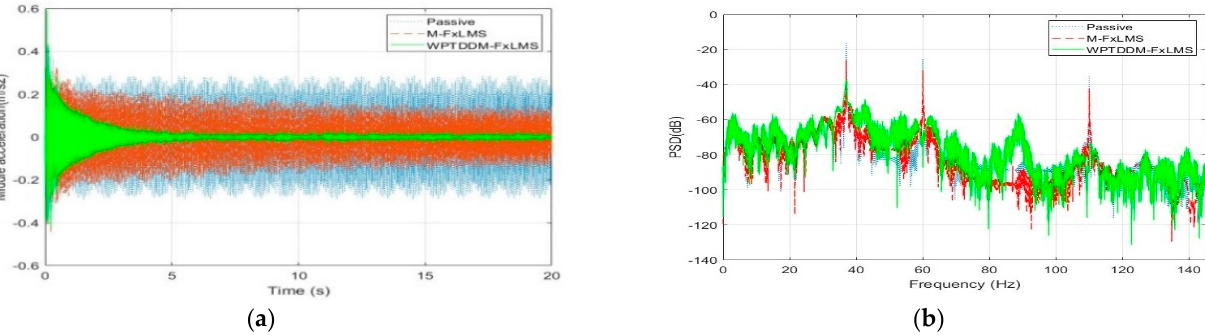
Figure 10. ( a ) The time domain acceleration signal in measuring point 1#; ( b ) the acceleration signal spectrum in measuring point 1#.